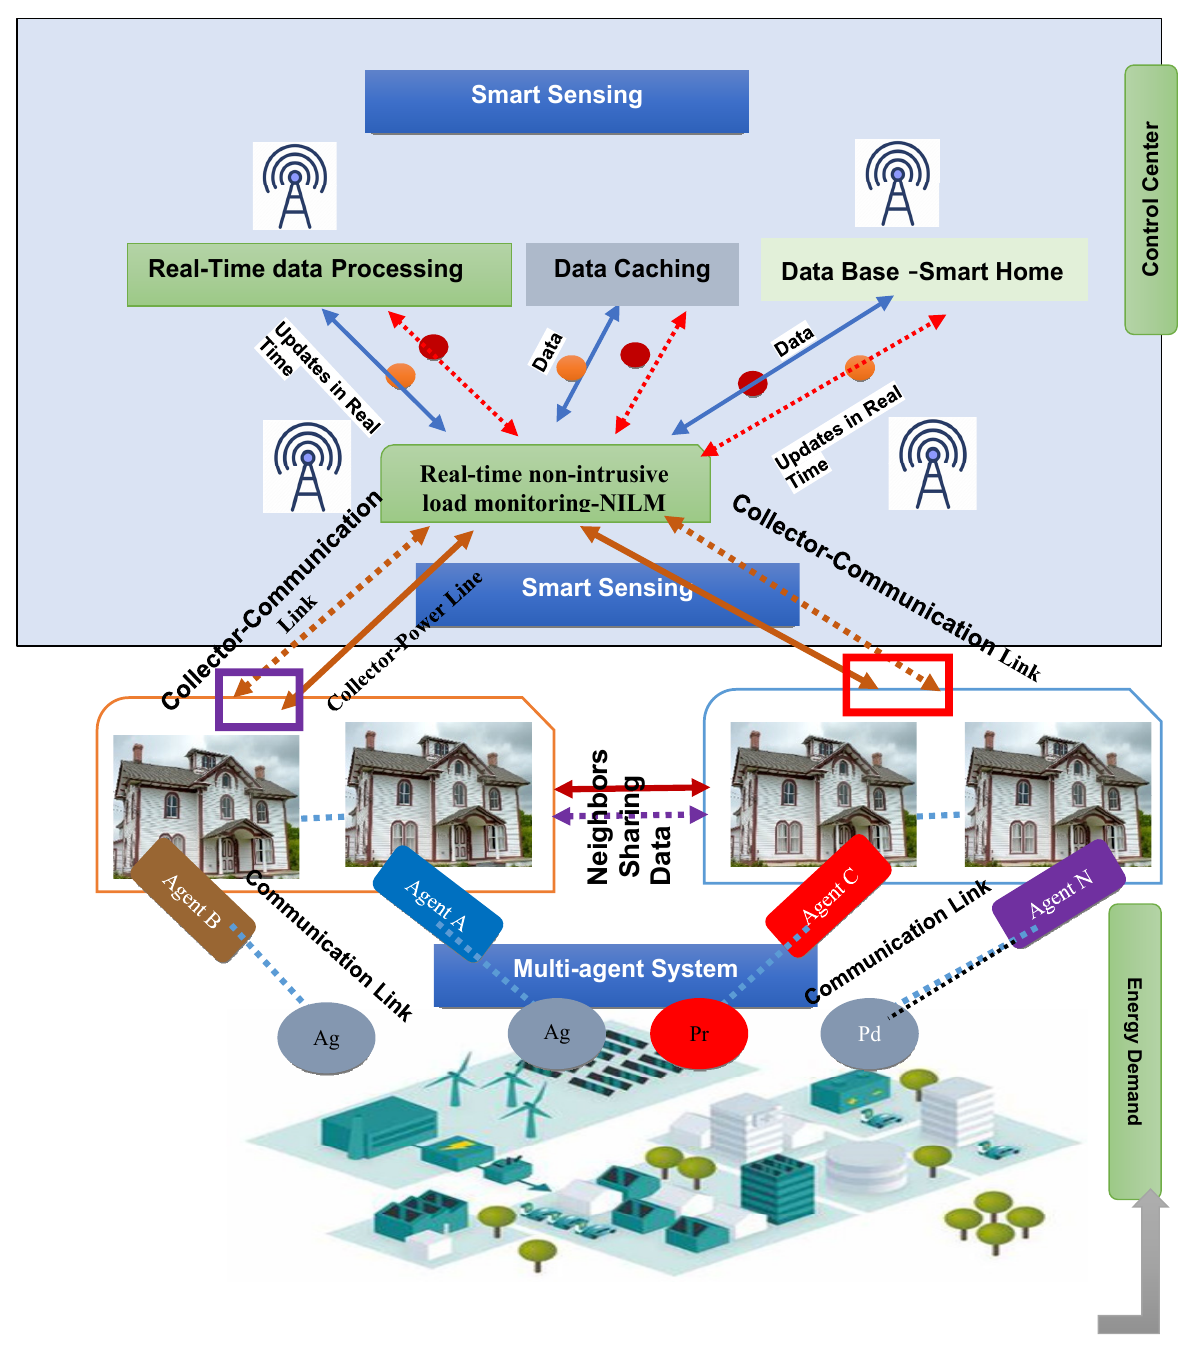
Figure 3. Agent in Smart Grid Model.